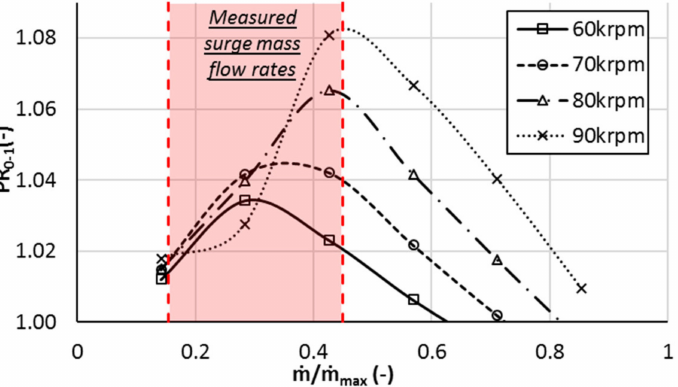
Figure 14. CFD-derived fan pressure ratio characteristic overlaid with experimentally measured surge mass flow